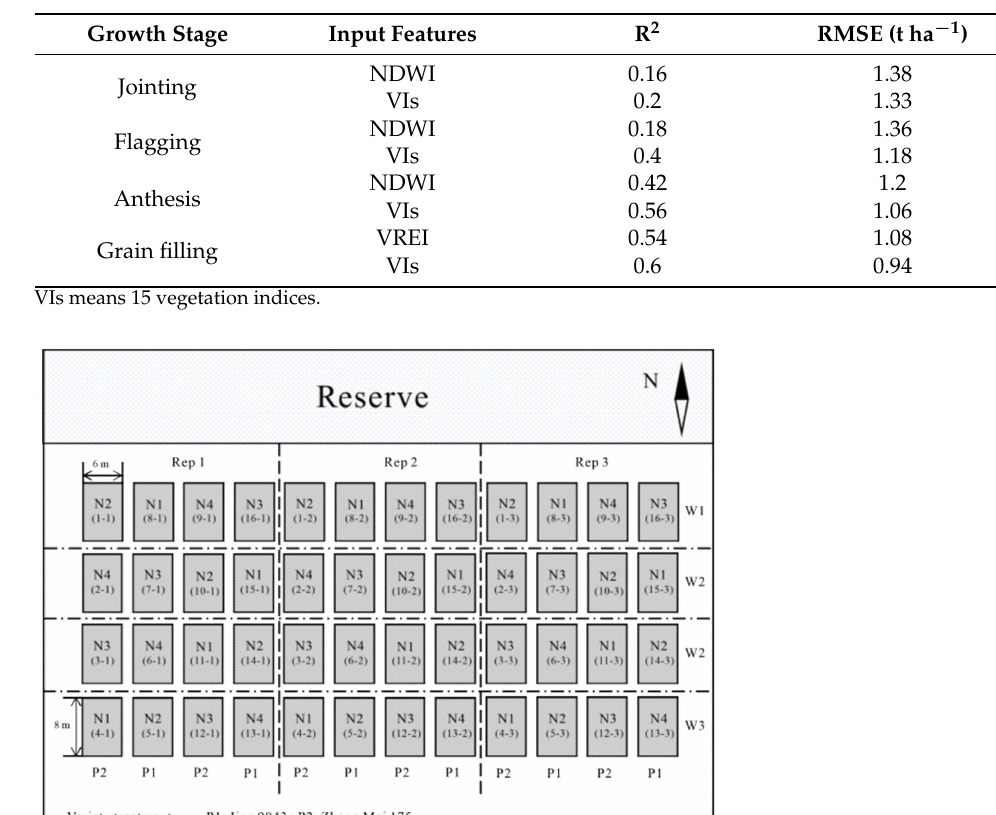
Table A7. Statistical analysis of GY prediction accuracy for a single optimal variable and multiple variables.